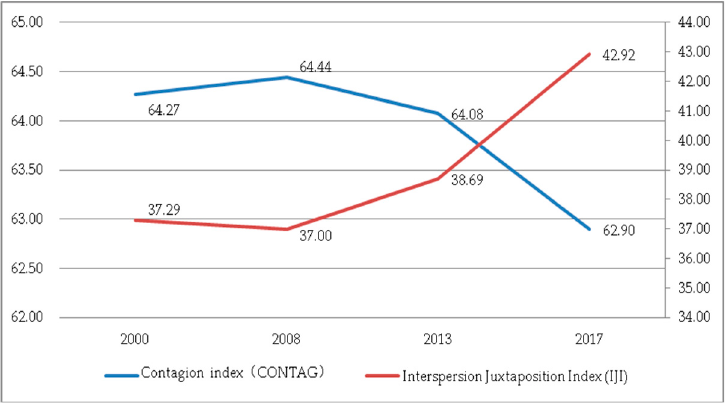
Figure 14. The Contagion Index (CONTAG) and IJI at the landscape level.